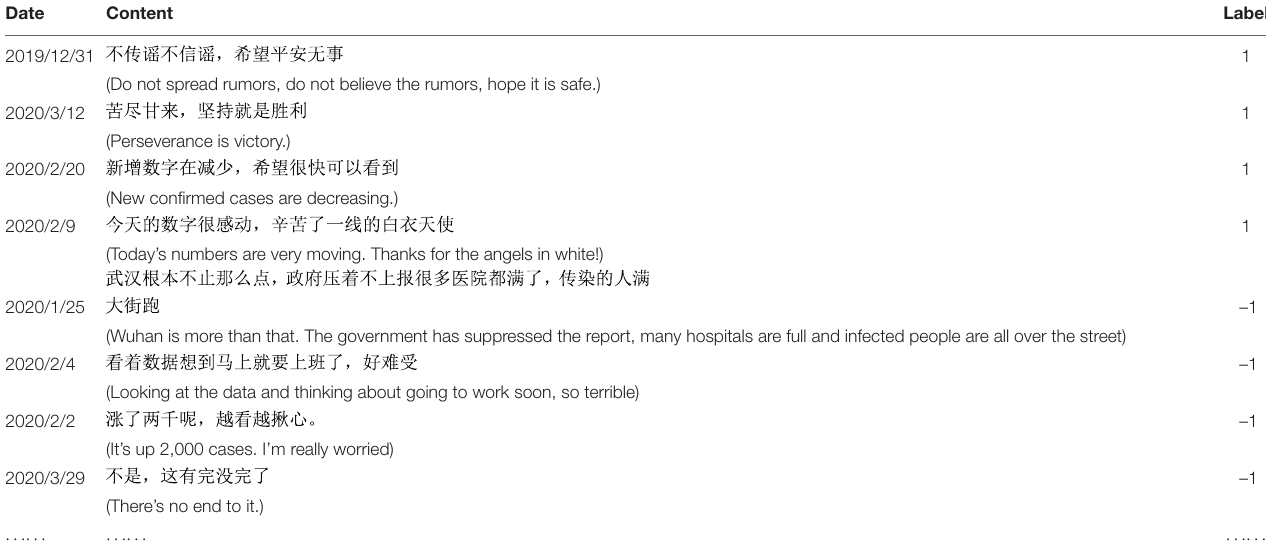
TABLE 3 | Artificial sentiment annotation comments.